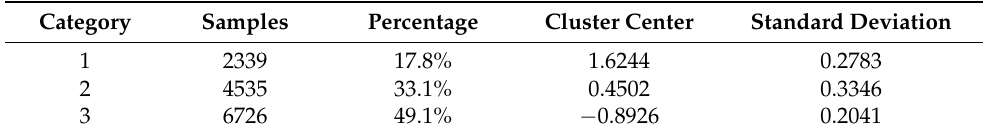
Figure 5. Cluster 3D distribution of two variables.